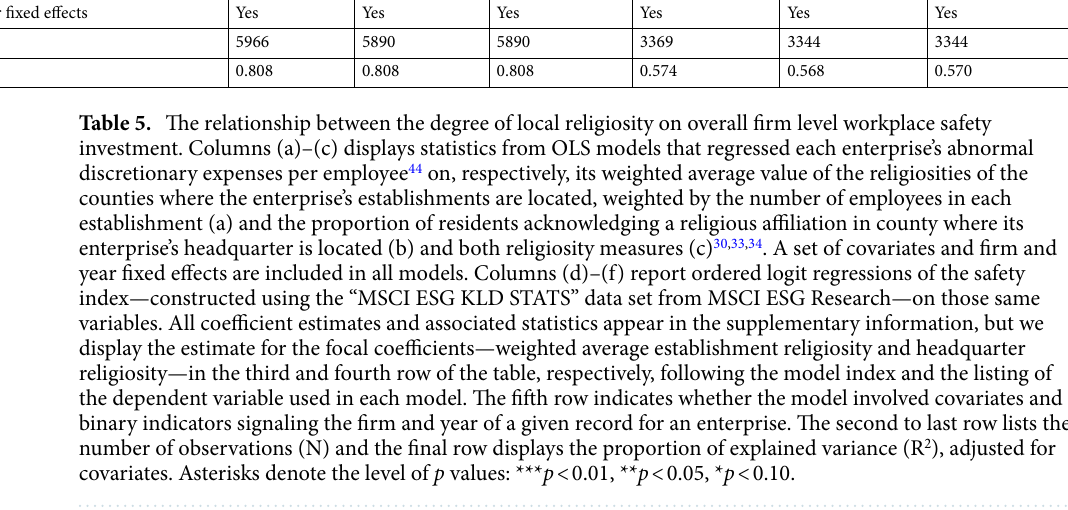
self-control and risk aversion in the population. We divided our sample into two groups—those above and below the median auto accident rate in the state where an establishment is located—and replicated the models from Table 1 on each subsample. As shown in Table 6, when studying the sub-sample of communities with above- median accident rates (in which we would expect religiously induced self-control to substitute for control lack- ing in the community), we find that regressing TCR on our focal predictor results in estimates that allow us to ˆ β = − 1.70 reject the null hypothesis of no relationship between outcome and predictor ( , SE = 0.73 , t = − 2.33 , p = 0.02 ). Estimates from the same regression performed on communities with below-median accident rates ˆ β = − 0.98 does not result in rejection of the null hypothesis ( , SE = 0.72 , t = − 1.38 , p = 0.17 ). When modeling the logarithm level of workplace injuries, we find comparable results. In the sub-sample of communities with